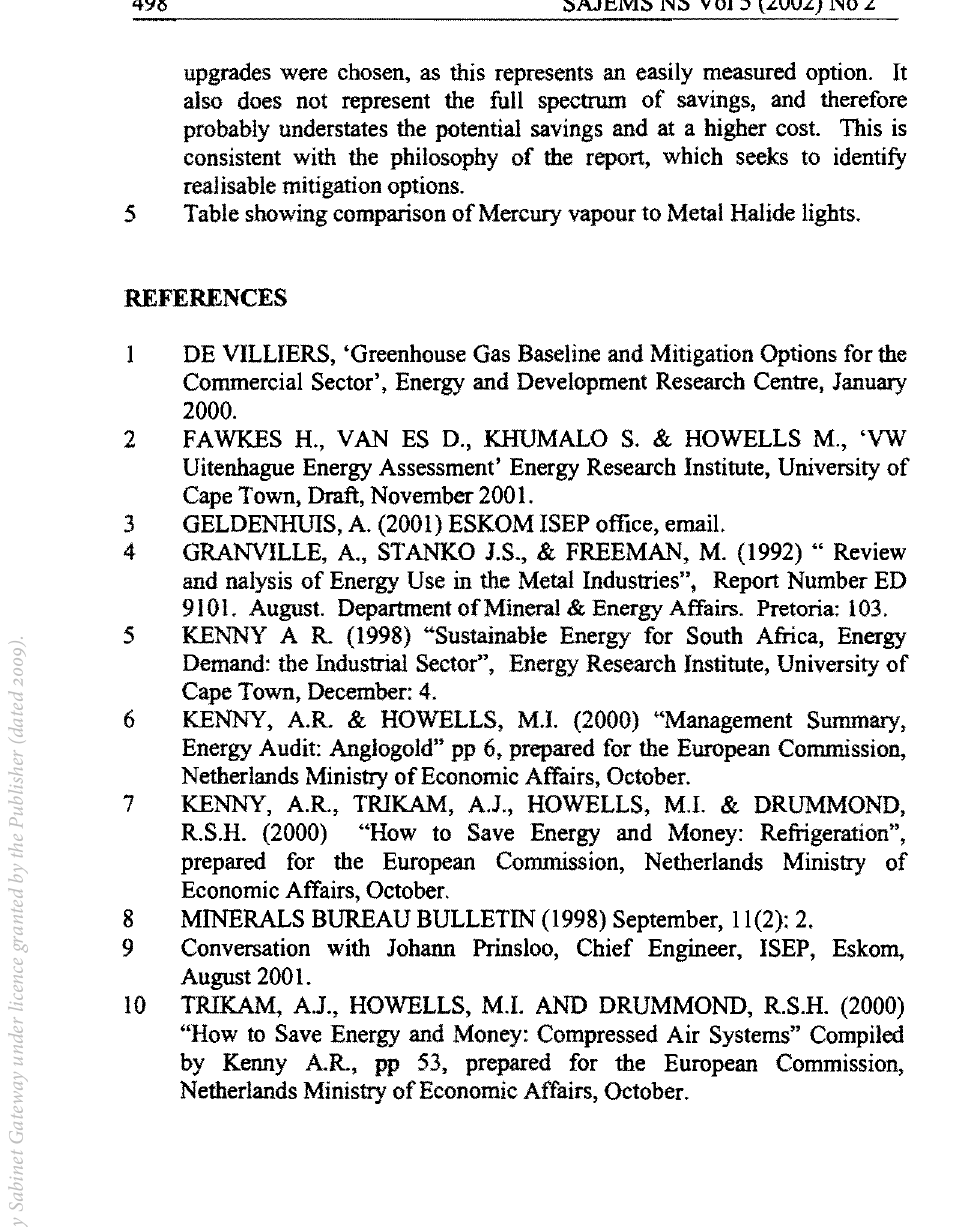
Table showing comparison of Mercury vapour to Metal Halide